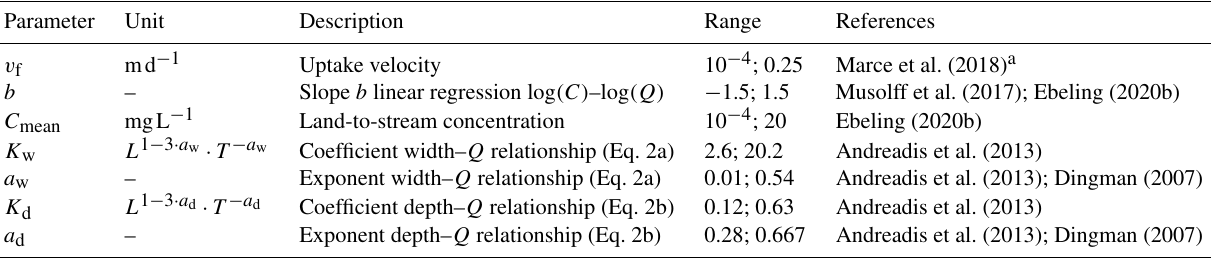
Table 1. Network model parameter ranges for the Monte Carlo simulations.